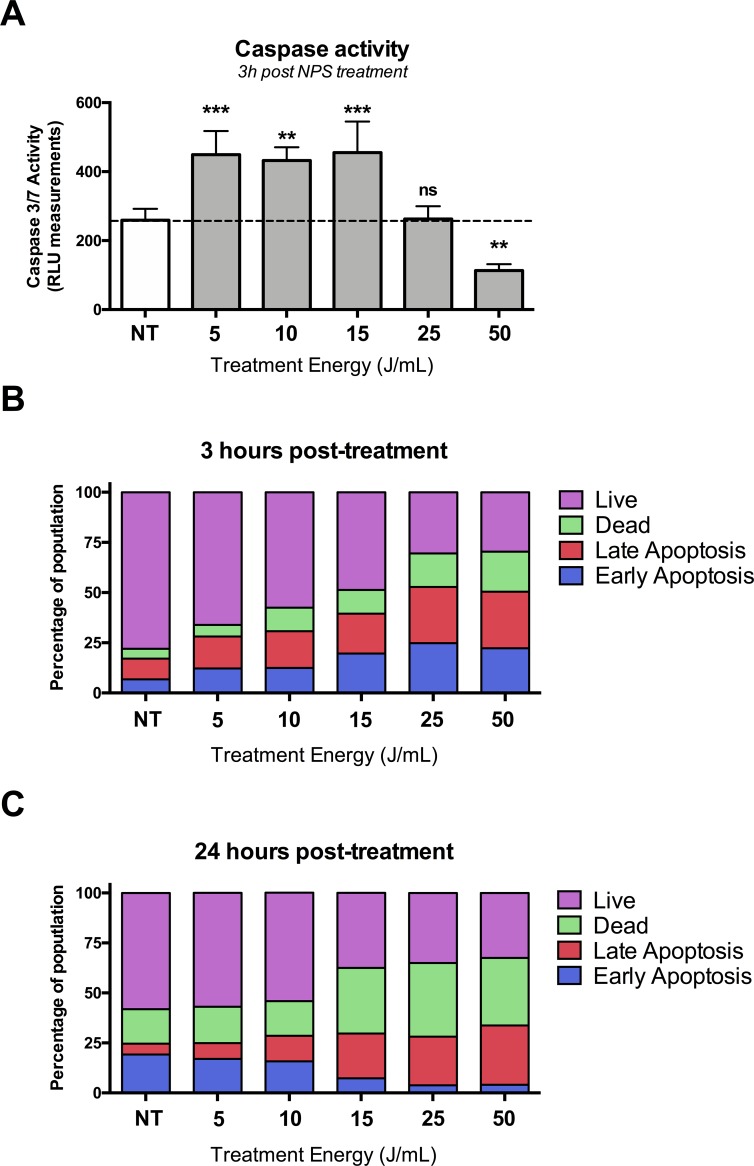
NPS treatment of C3.43 cells results in significant upregulation of caspase 3/7 activity at lower treatment energies.(A) Measured levels of activated caspase 3/7 in cells at 3h post NPS treatment for a range of NPS energy densities. Data shown as the mean of 4 experiments and the error bars represent the standard error of the mean (**p<0.01 ***p<0.001, One-way ANOVA followed by Dunnett’s multiple comparisons test to untreated cells). (B) Mean distribution of treated C3.43 tumor cells in early and late apoptosis at 3 h post-treatment with indicated NPS energy density (C) Data collected 24 h post NPS treatment.